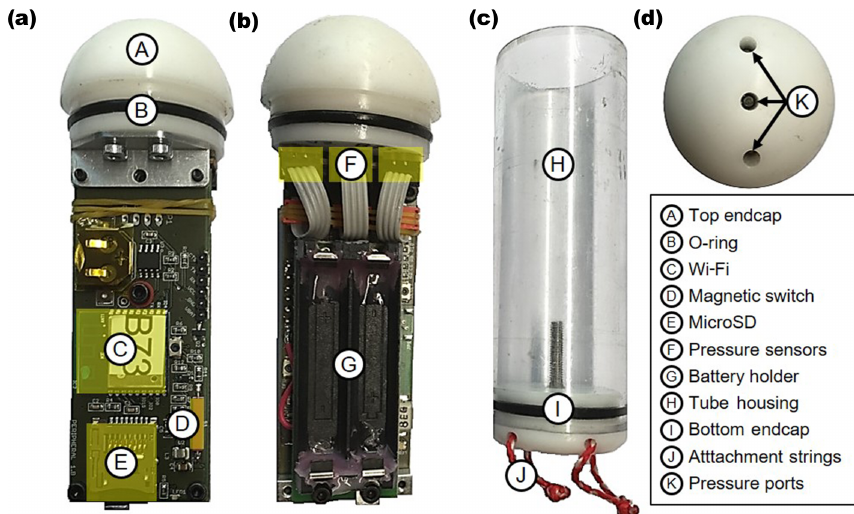
Figure 2. Detailed breakdown of the drifter. (a) Side view showing the drifter electronics. (b) Side view showing the reverse side of the electronics board including the battery holder and pressure sensors. (c) Polycarbonate tube housing of the drifters with attachment strings for balloons used for manual buoyancy adjustment. (d) Top view facing the cap, showing the ports for each of the three pressure